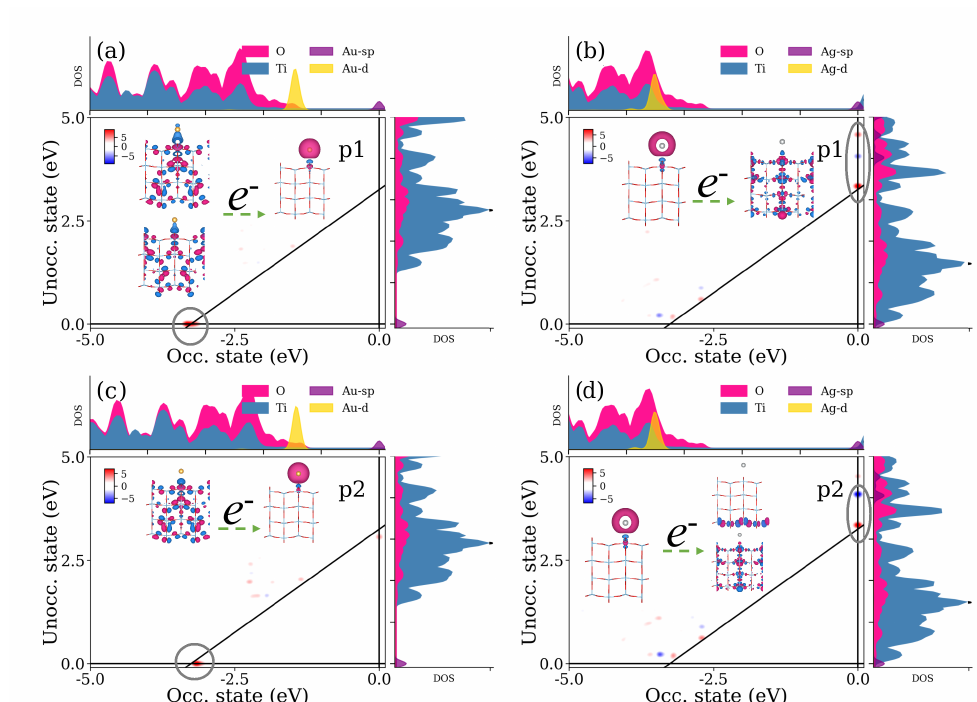
Figure 4. TCM of deposited Au ( a , c ) and Ag ( b , d ) Me s for the suspended Me s at p1 (first row, ( a , b )) and p2 (second row, ( c , d )) positions. The diagonal solid lines are used to emphasize the constant transition energy at 3.25 eV. DOS includes Ti, O, Me s sp -orbitals and Me s d -orbitals, which are the same as in Figure 2. The insets present the orbitals contributing in Me s charge transition, which are marked by circle (Au) and ellipse